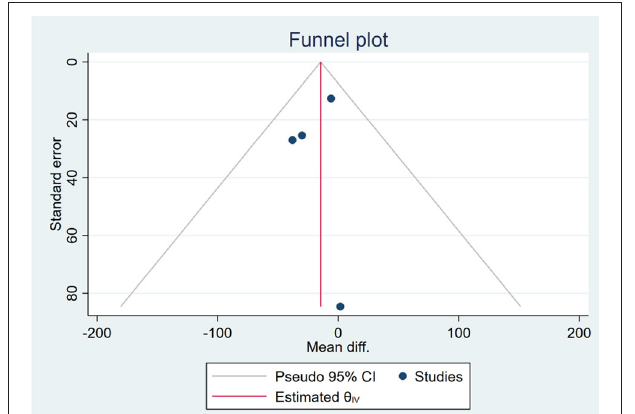
FIGURE 28 | Funnel plots of the effect of LDL-C.